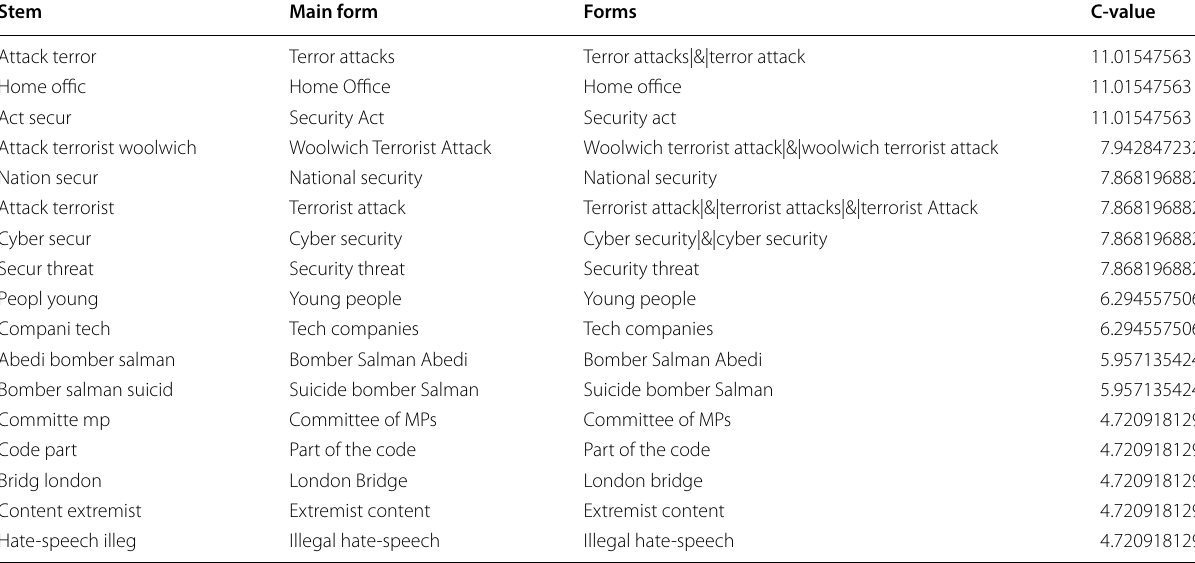
Table 7 C-value on topics presented by actors online (based on abstract of articles/web pages)